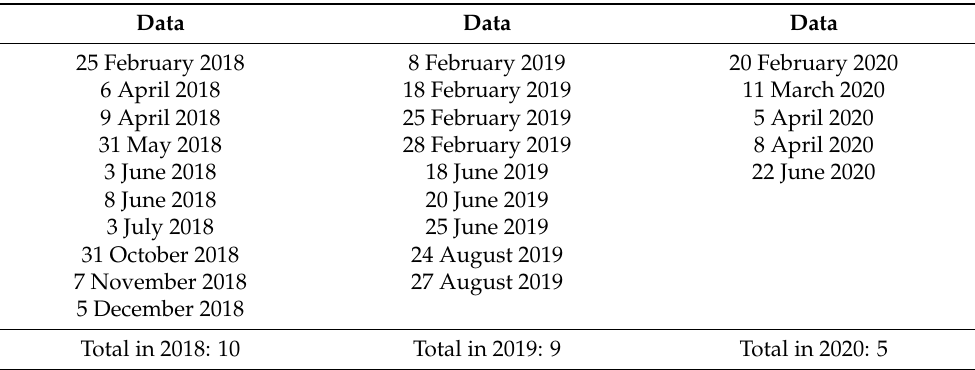
Table 2. Acquisition dates of final selected Sentinel-2 data.